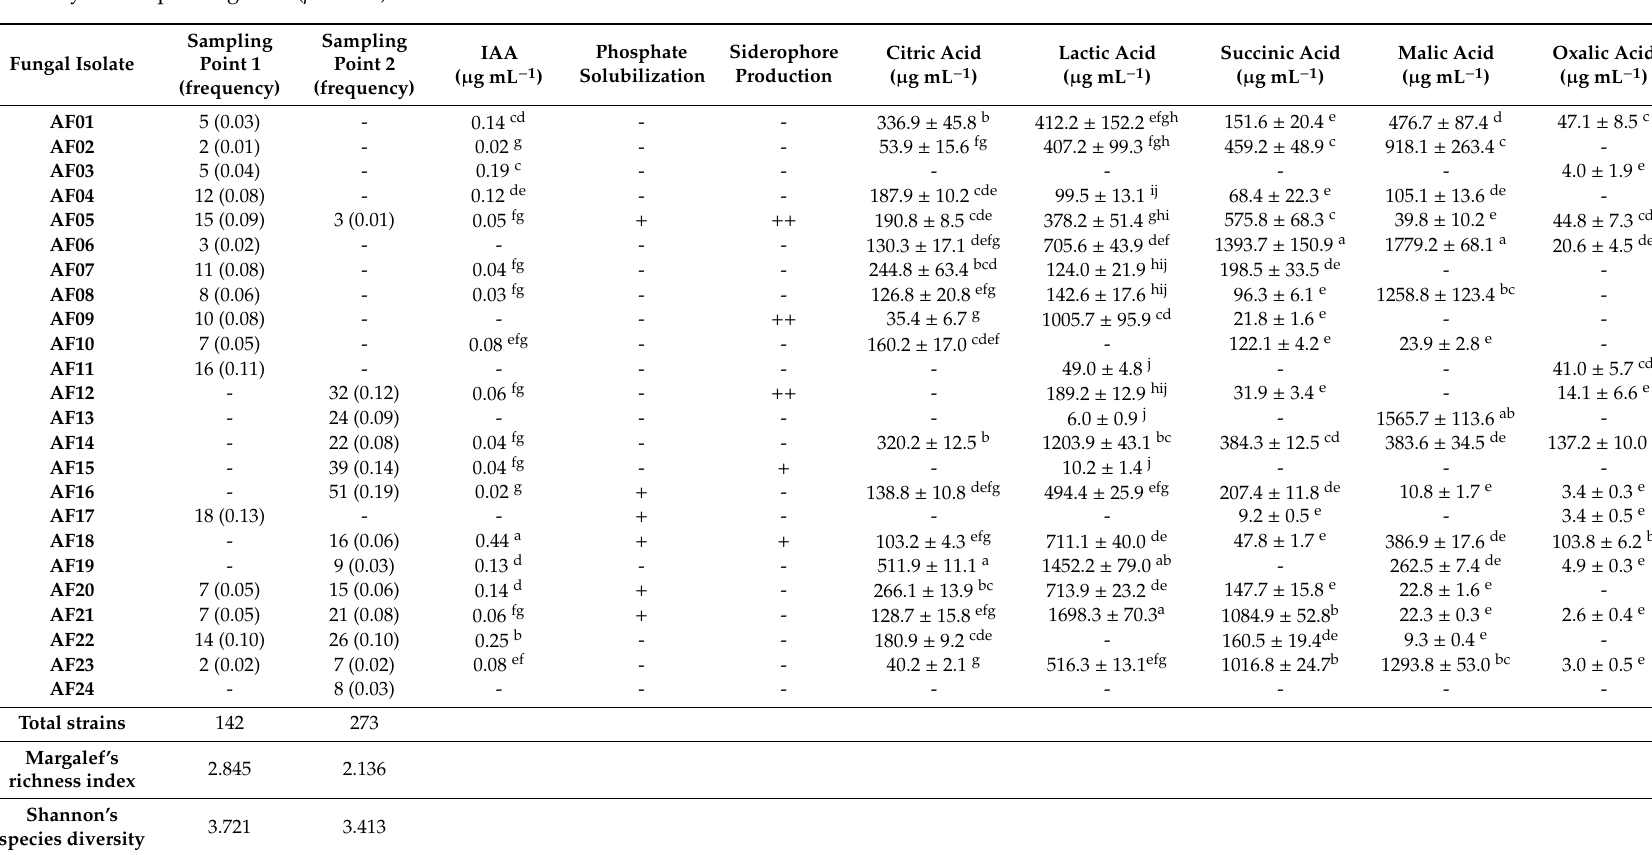
Table 2. Screening of potential plant-growth-promoting traits and abundance of rhizospheric and endophytic fungi isolated from Arachnitis uniflora roots from the Coastal Mountains in southern Chile. Results are means ± standard error ( n = 5). Di ff erent letters indicate significant di ff erences between treatments according to Tukey’s multiple range test ( p <